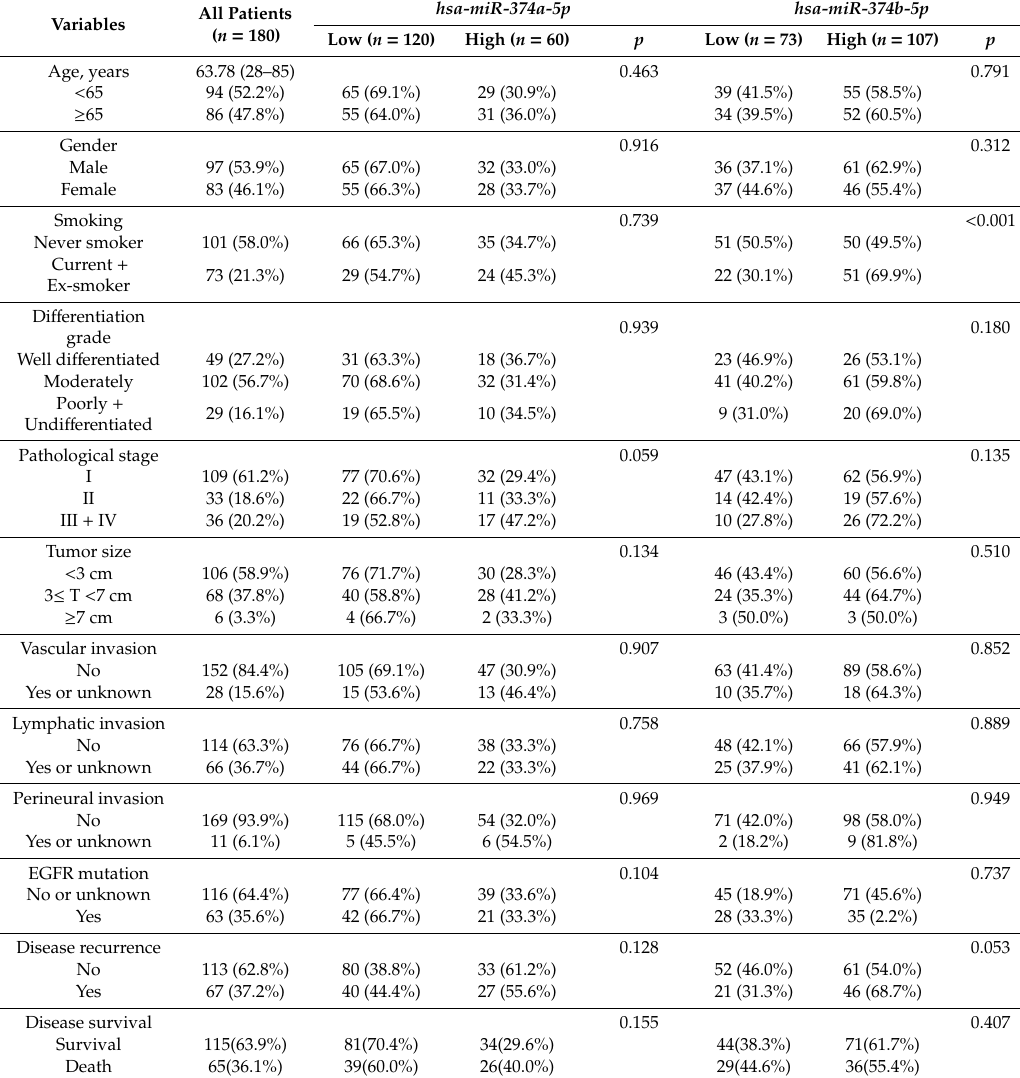
Table 1. Baseline characteristics of LUAD patients stratified based on miR-374a or miR-374b